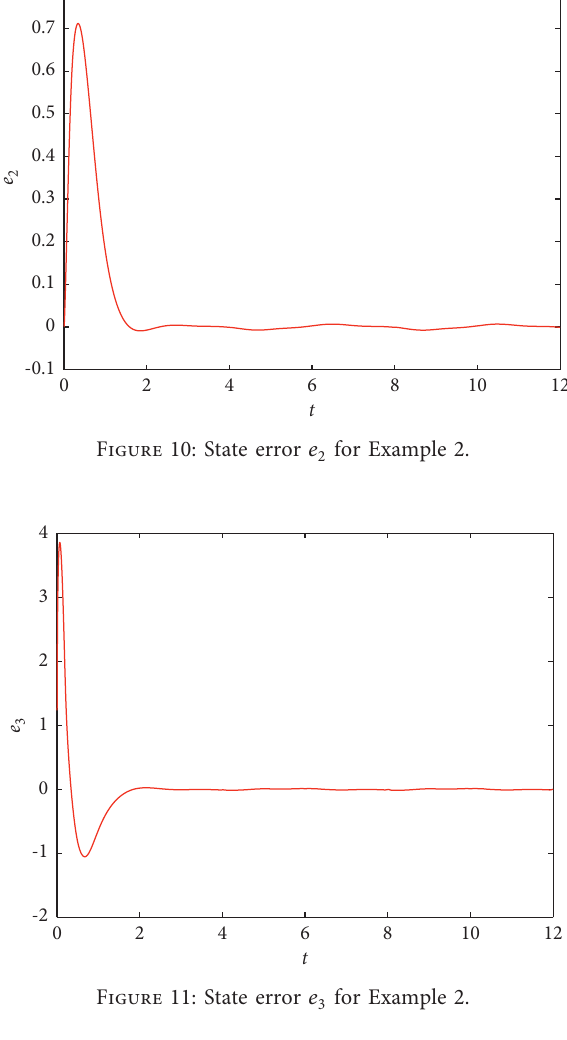
for Example 2. 3